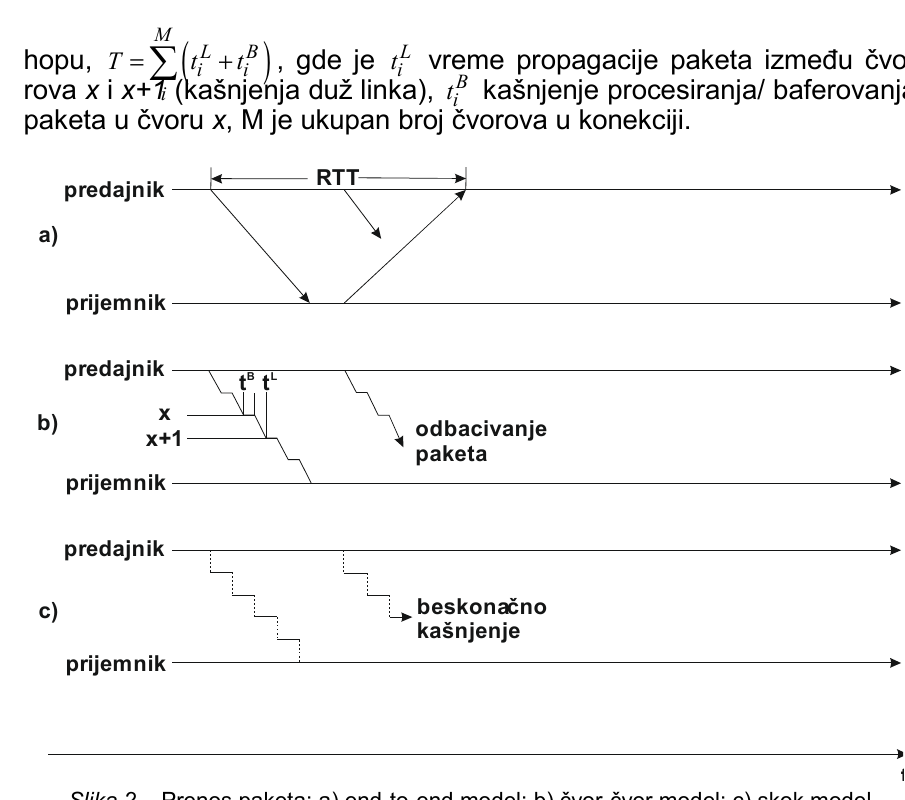
Figure 2 – Packet transmission: a) end-to-end model; b) node-node model; c) jump model Схема 2 – Передача пакета : а ) модель end-to-end б ) модель узел - узел с ) модель